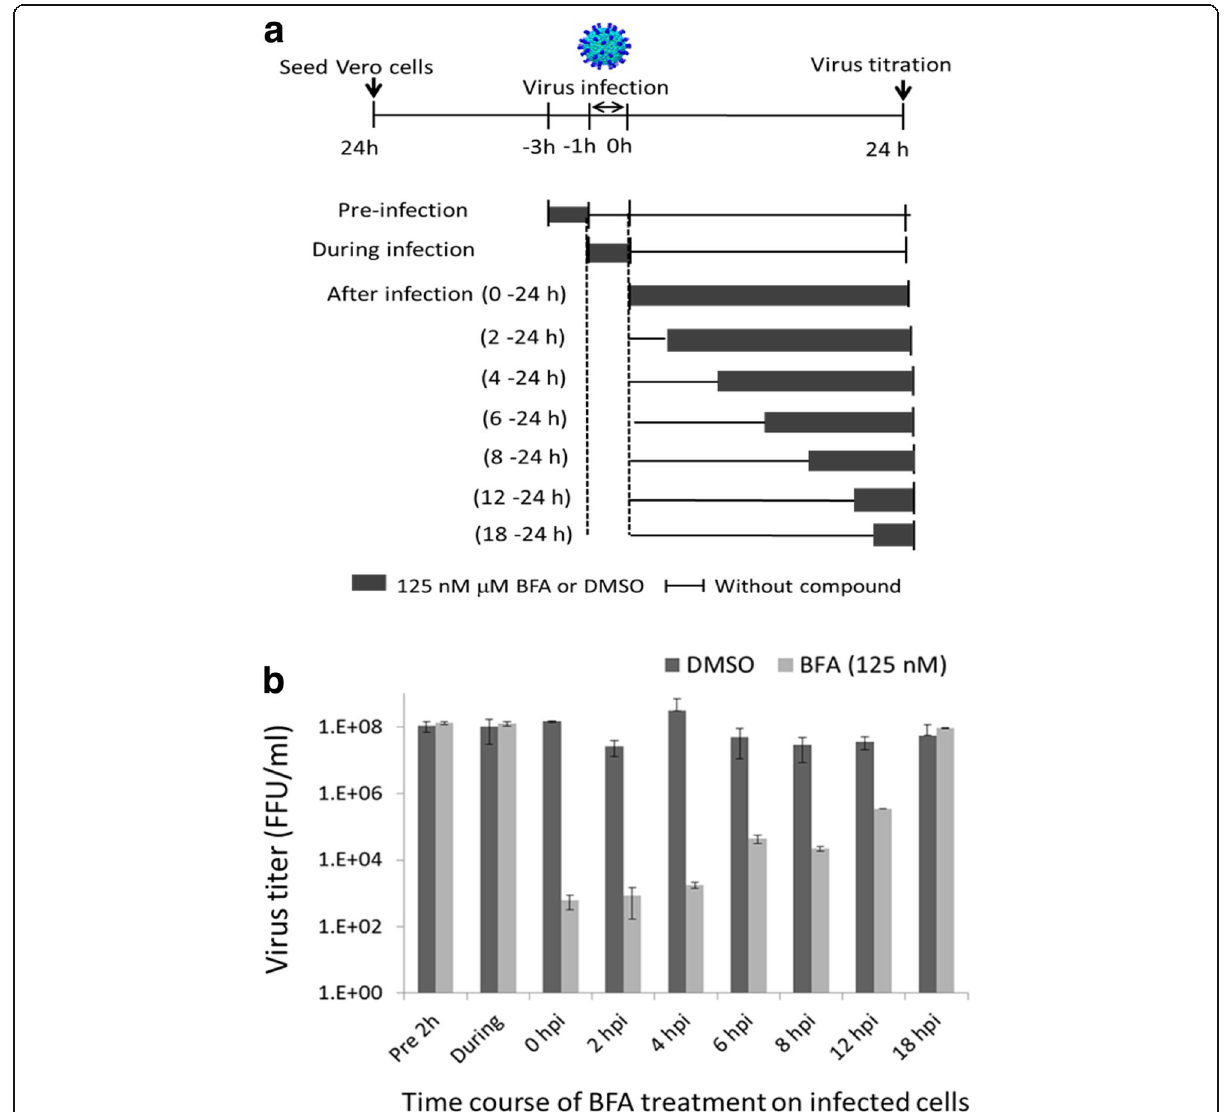
Fig. 4 Time-of-addition studies. a Schematic illustration of time-of-addition studies for treatment with BFA. Vero cells in 96-well plates were treated with 125 nM BFA at different time points before, during, and after DENV infection (MOI of 5). For after-infection assay, BFA was added at seven different time points after virus exposure. b After 24 h postinfection, released virus titer was determined by focus assay as described in the “ Materials and methods ” section. Error bars represent standard errors of two independent